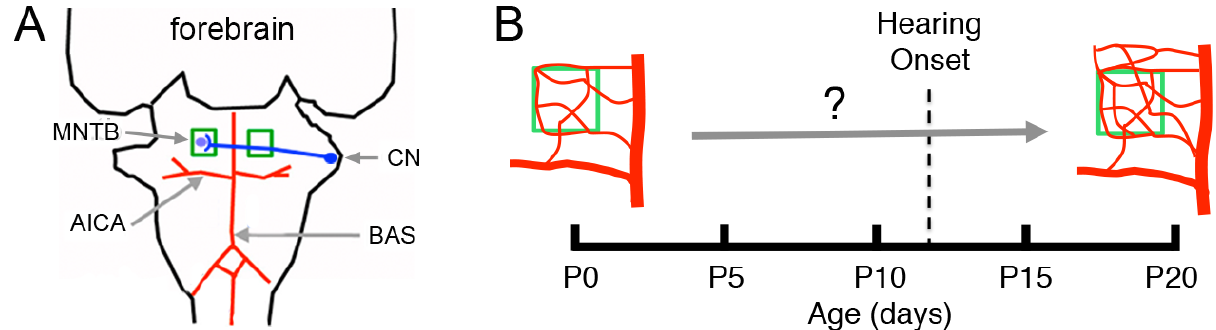
Figure 1. Main vascular supply to the ventral brainstem and hypothesis. ( A ) The anterior inferior cerebellar artery (AICA) is a main branch of the basilar artery (BAS). The BAS and AICA branch further to form the vascular beds that supply the brainstem. Neurons in the cochlear nucleus (CN, drawn in blue) connect synaptically with neurons in the contralateral medial nucleus of the trapezoid body (MNTB, enclosed in green squares). Little is known about the development of the MNTB vasculature. ( B ) It is hypothesized that the vasculature of the MNTB matures during the postnatal period before the onset of hearing.